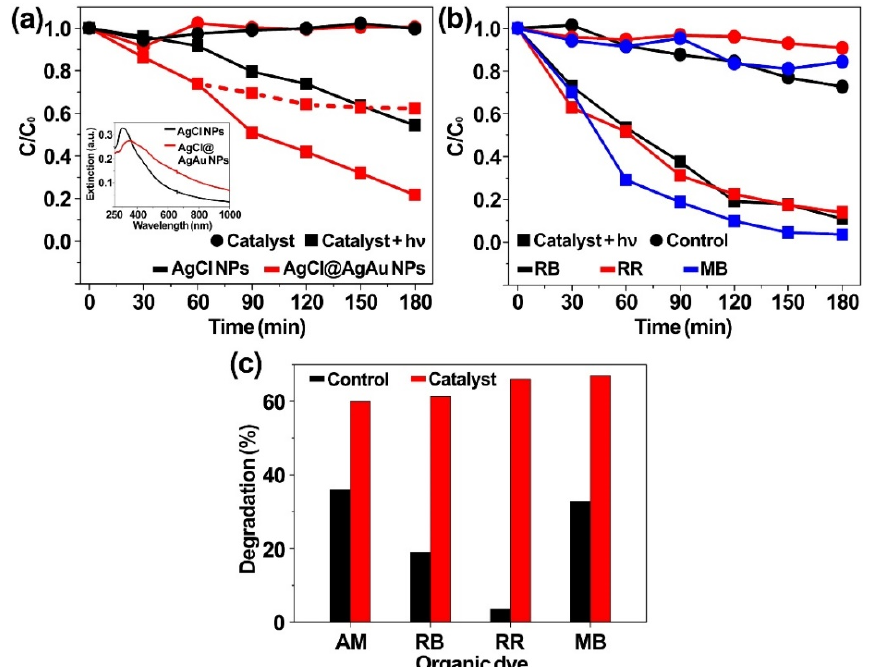
Figure 6. ( a ) Time-dependent photocatalytic degradation of amaranth (5 mM) with the AgCl NPs (black) and the AgCl@AgAu NPs (red). The progress of the reactions without visible light irradiation is plotted using circles, while the one with visible light irradiation is plotted using squares. The dashed line indicates the progress of the reactions after stopping the visible light irradiation at 60 min. ( b ) Time-dependent photocatalytic degradation of multiple organic dyes (rhodamine B (RB), Reactive Red 120 (RR), and methylene blue (MB)). The progress of the reactions with visible light but without catalysts is plotted using circles, while the one with visible light and catalysts is plotted using squares. ( c ) Degradation of each harmful organic dye in natural media (Han River, Seoul, Republic of Korea) with and without the AgCl@AgAu NPs under the visible light irradiation after 3 h.